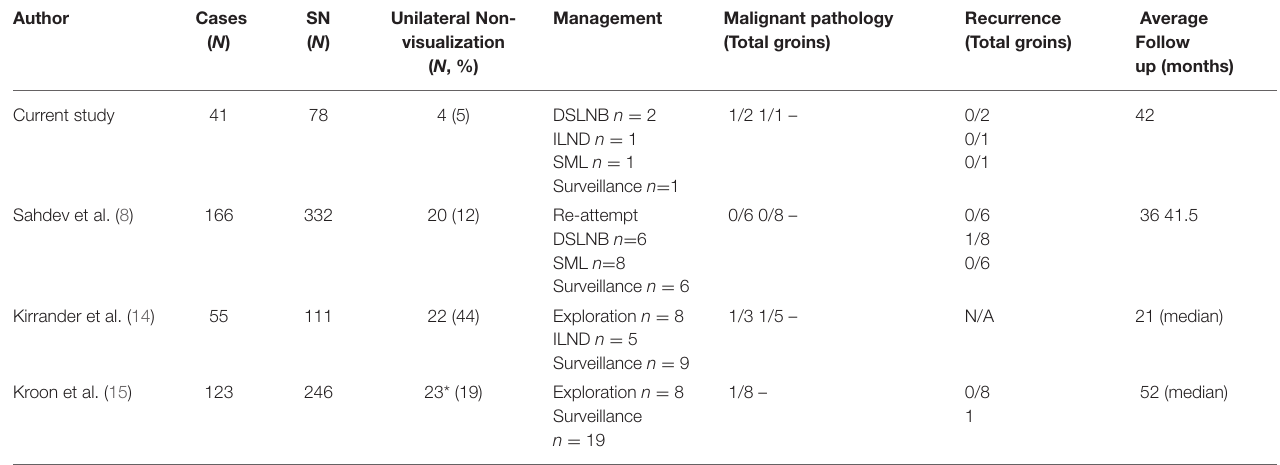
TABLE 2 | Summary of SN